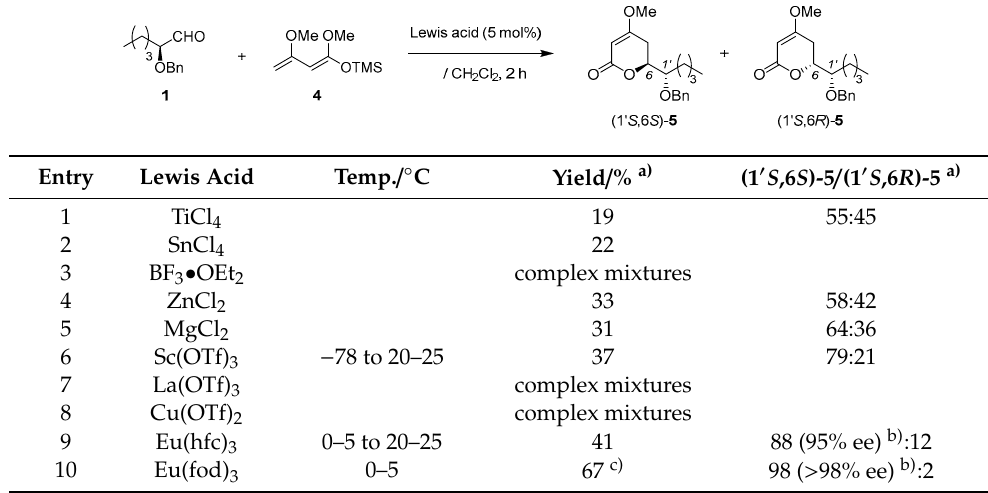
Table 2. Stereoselective catalytic hetero-Diels-Alder reaction using Brassard’s siloxydiene.